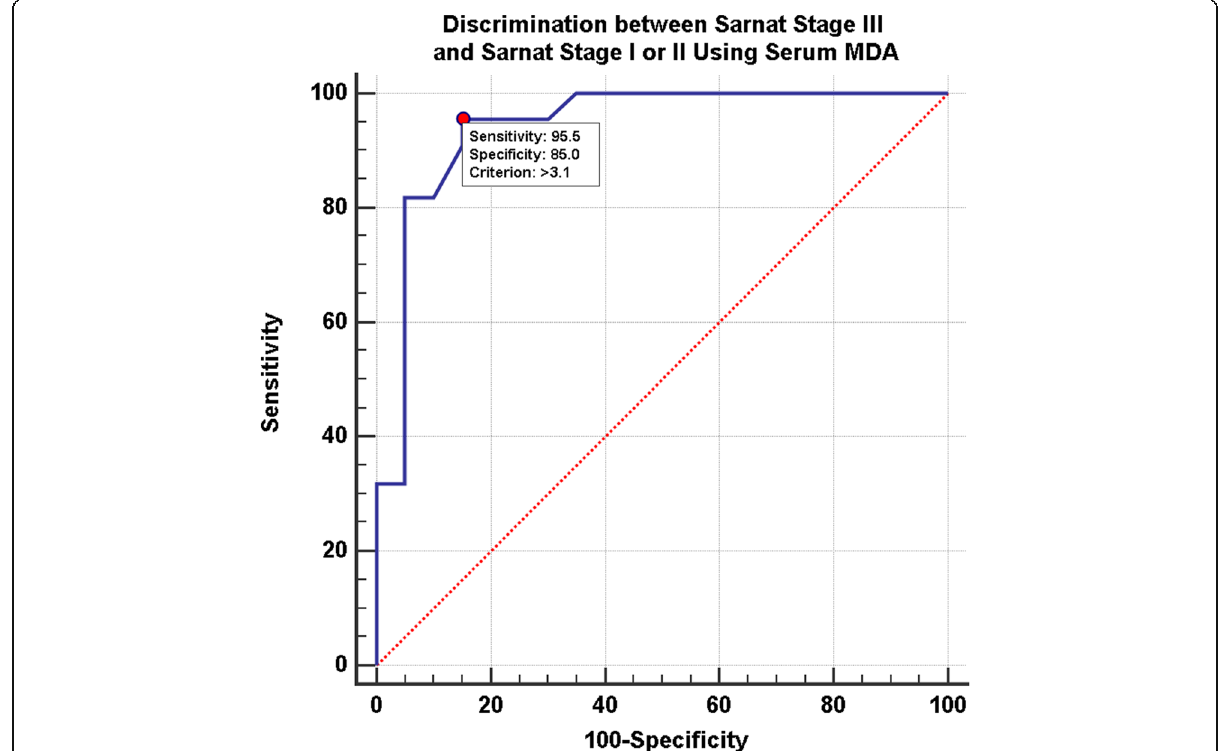
Fig. 5 ROC curve for discrimination between Sarnat stage III and Sarnat stage I or II patients using serum MDA levels. Area under the curve was